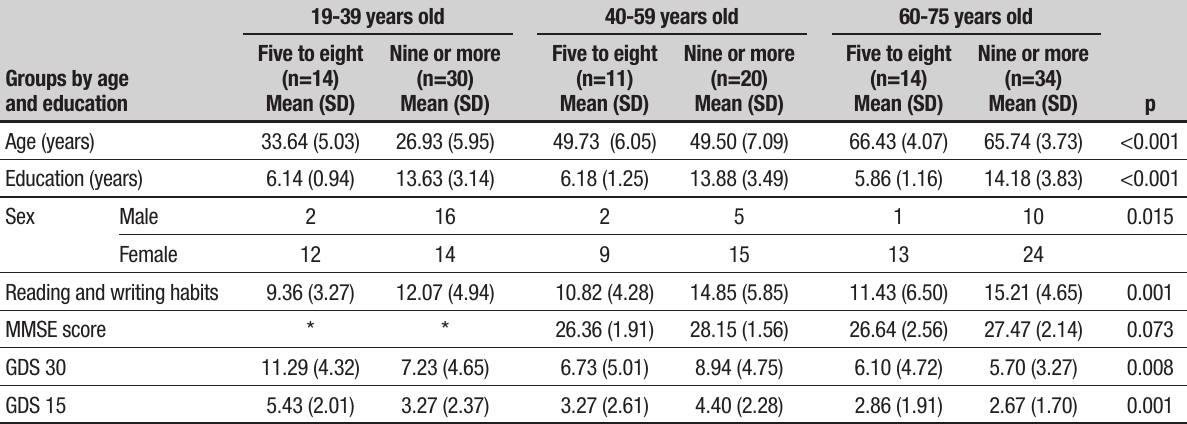
Table 2. Sociodemographic, cultural and clinical characteristics of preliminary normative groups for Digit span test.